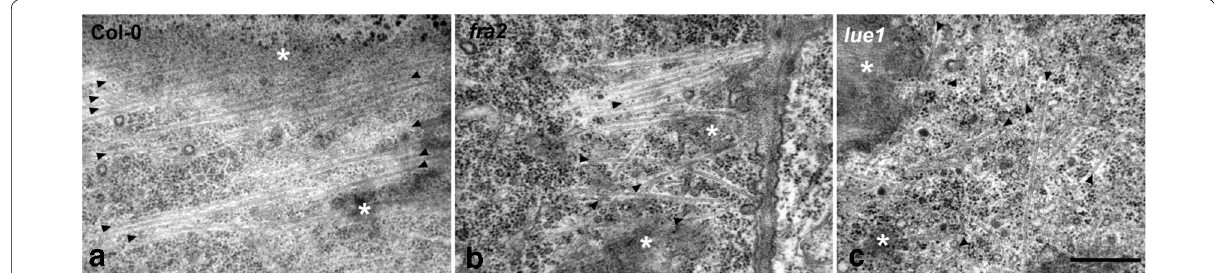
Fig. 5 TEM micrographs of cortex cells at tangential sections through the cortical cytoplasm. In the wild‑type ( a ), transverse microtubules (arrowheads) uniformly parallel to each other can be observed. In fra2 ( b ) and lue1 ( c ), microtubules (arrowheads) follow a random pattern. The asterisks mark grazing sectioned parts of cortex cell walls. Scale bar 400